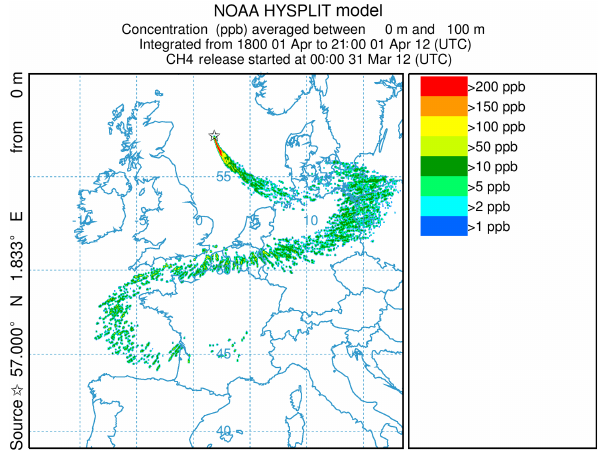
Figure 2. Example of a prospective HYSPLIT model of the CH 4 plume at 12:00UTC, 2 April 2012. This assumed that the release rate was 23.5kgs − 1 for the previous three days (see text for